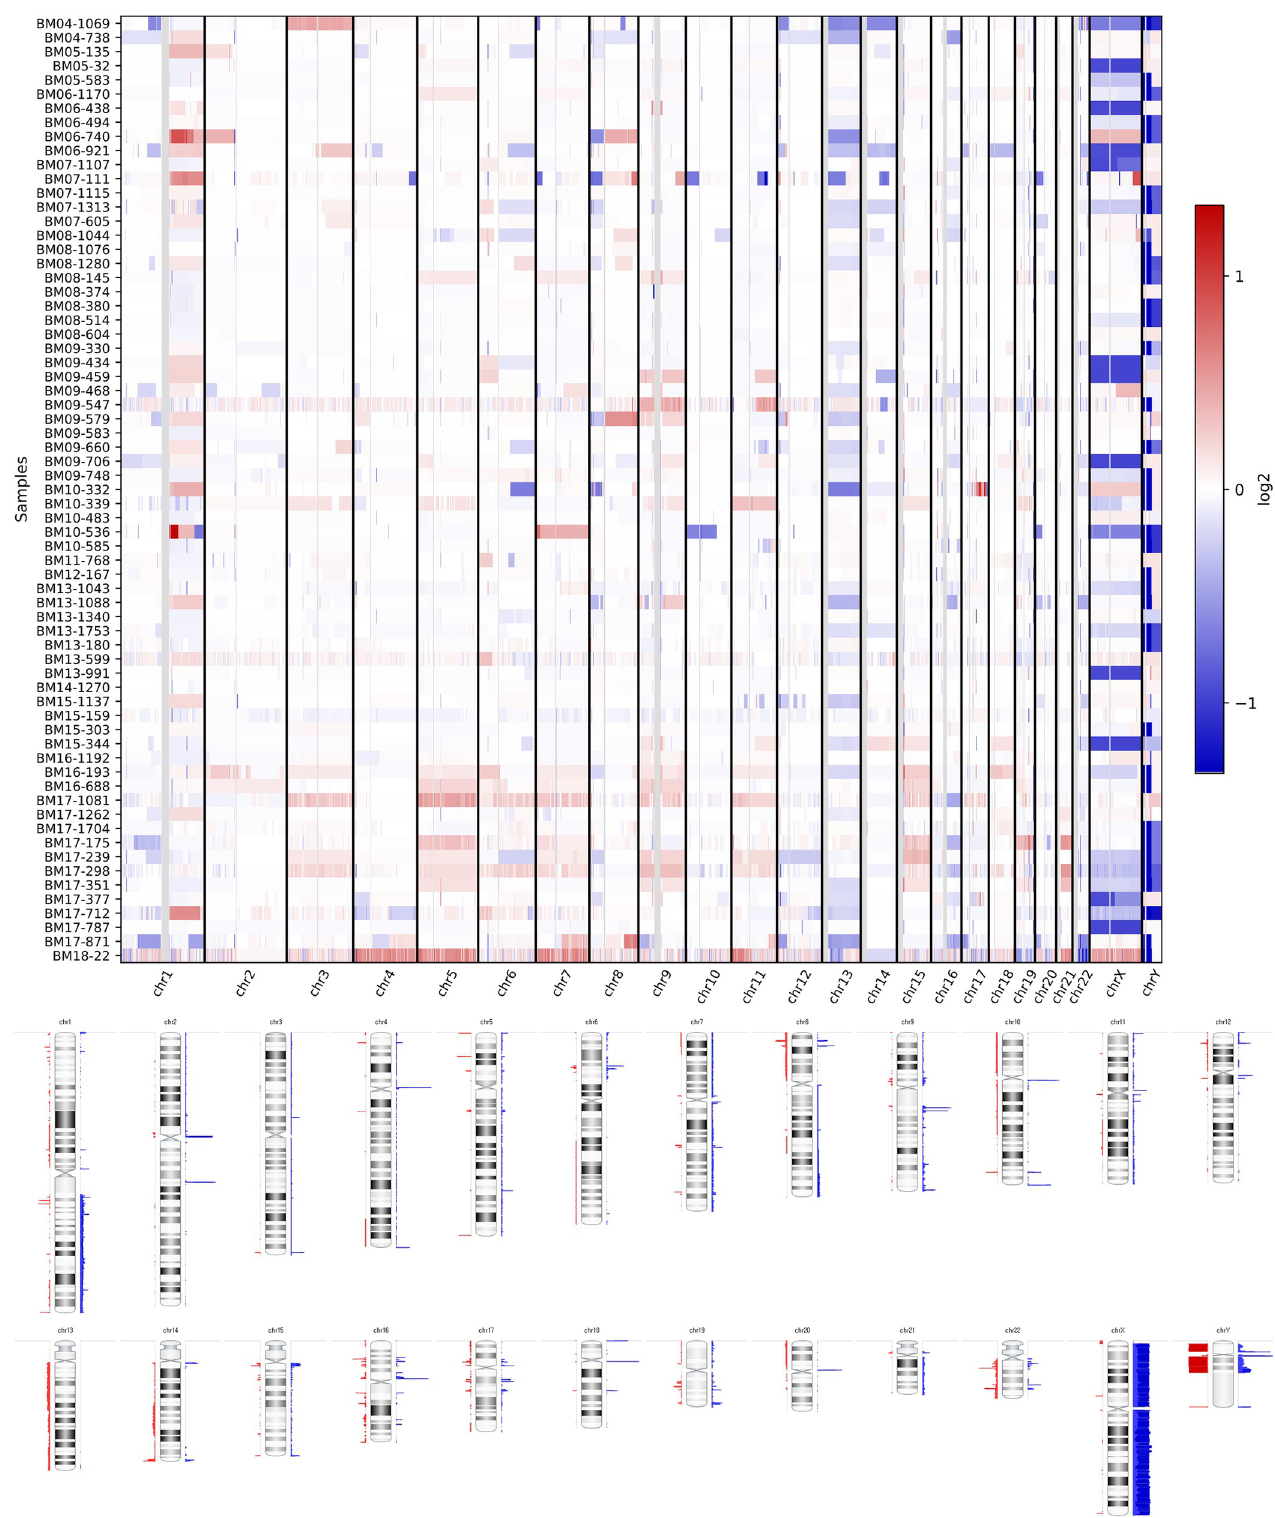
Fig 1. Summary plot of chromosomal gain and loss in 67 patients with newly diagnosed multiple myeloma determined using whole-exome sequencing and copy number analysis. (A) In the heatmap plot, each row represents one patient, while each column represents chromosomes 1–23, X, and Y in order. (B)